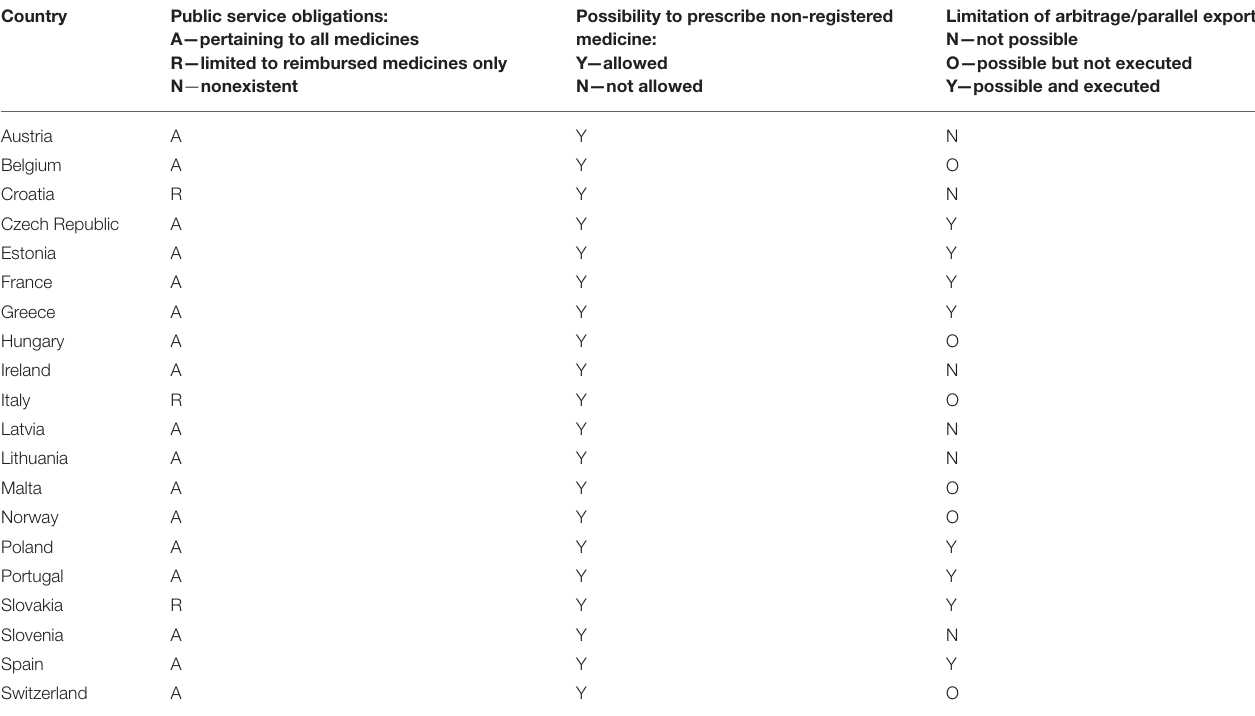
TABLE 5 | The summary information on measures influencing trade rules of the European Union and the European Free Trade Association. Country